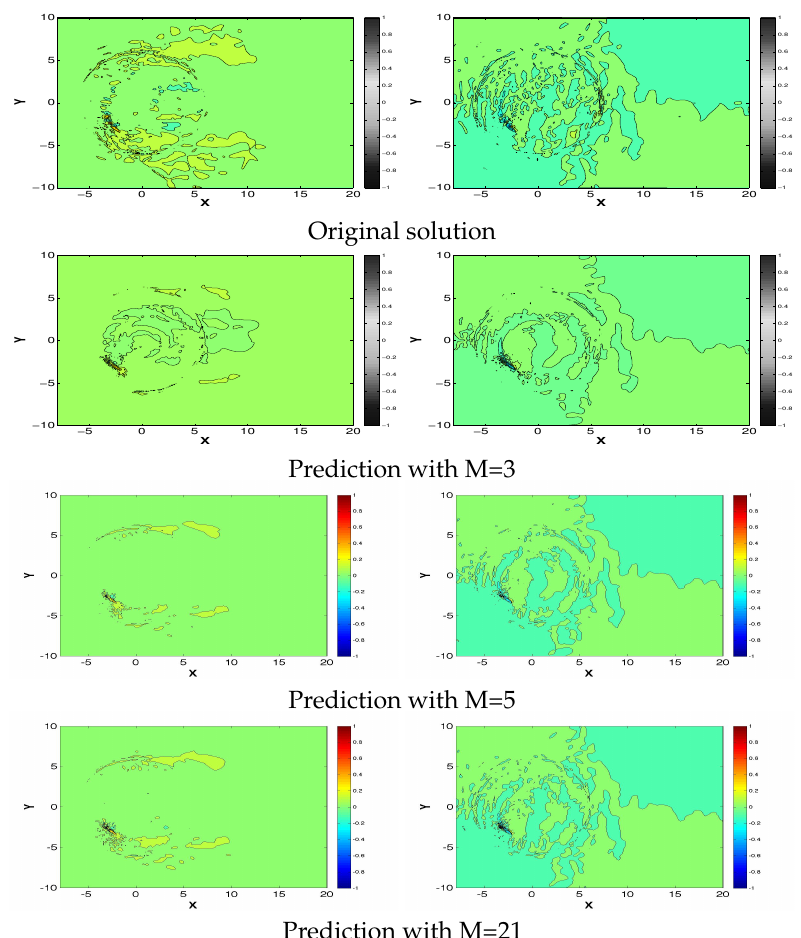
Figure 6. One-blade wind turbine case: streamwise ( left ) and normal ( right ) velocities, u x and u y , of the instantaneous flow field at time instant 240 s. Two-dimensional x − y cross section at z = 0.9375